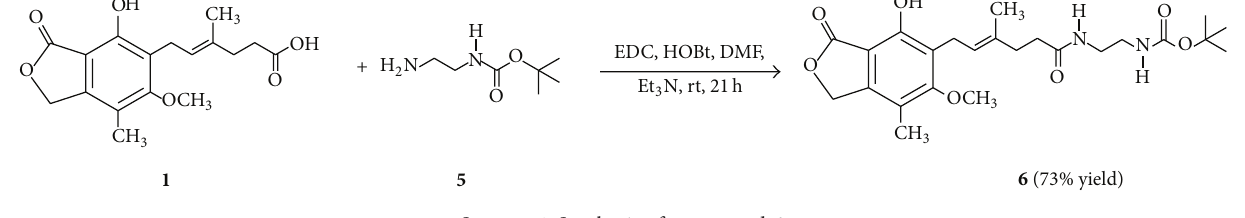
Scheme 1: Synthesis of compound 6 .